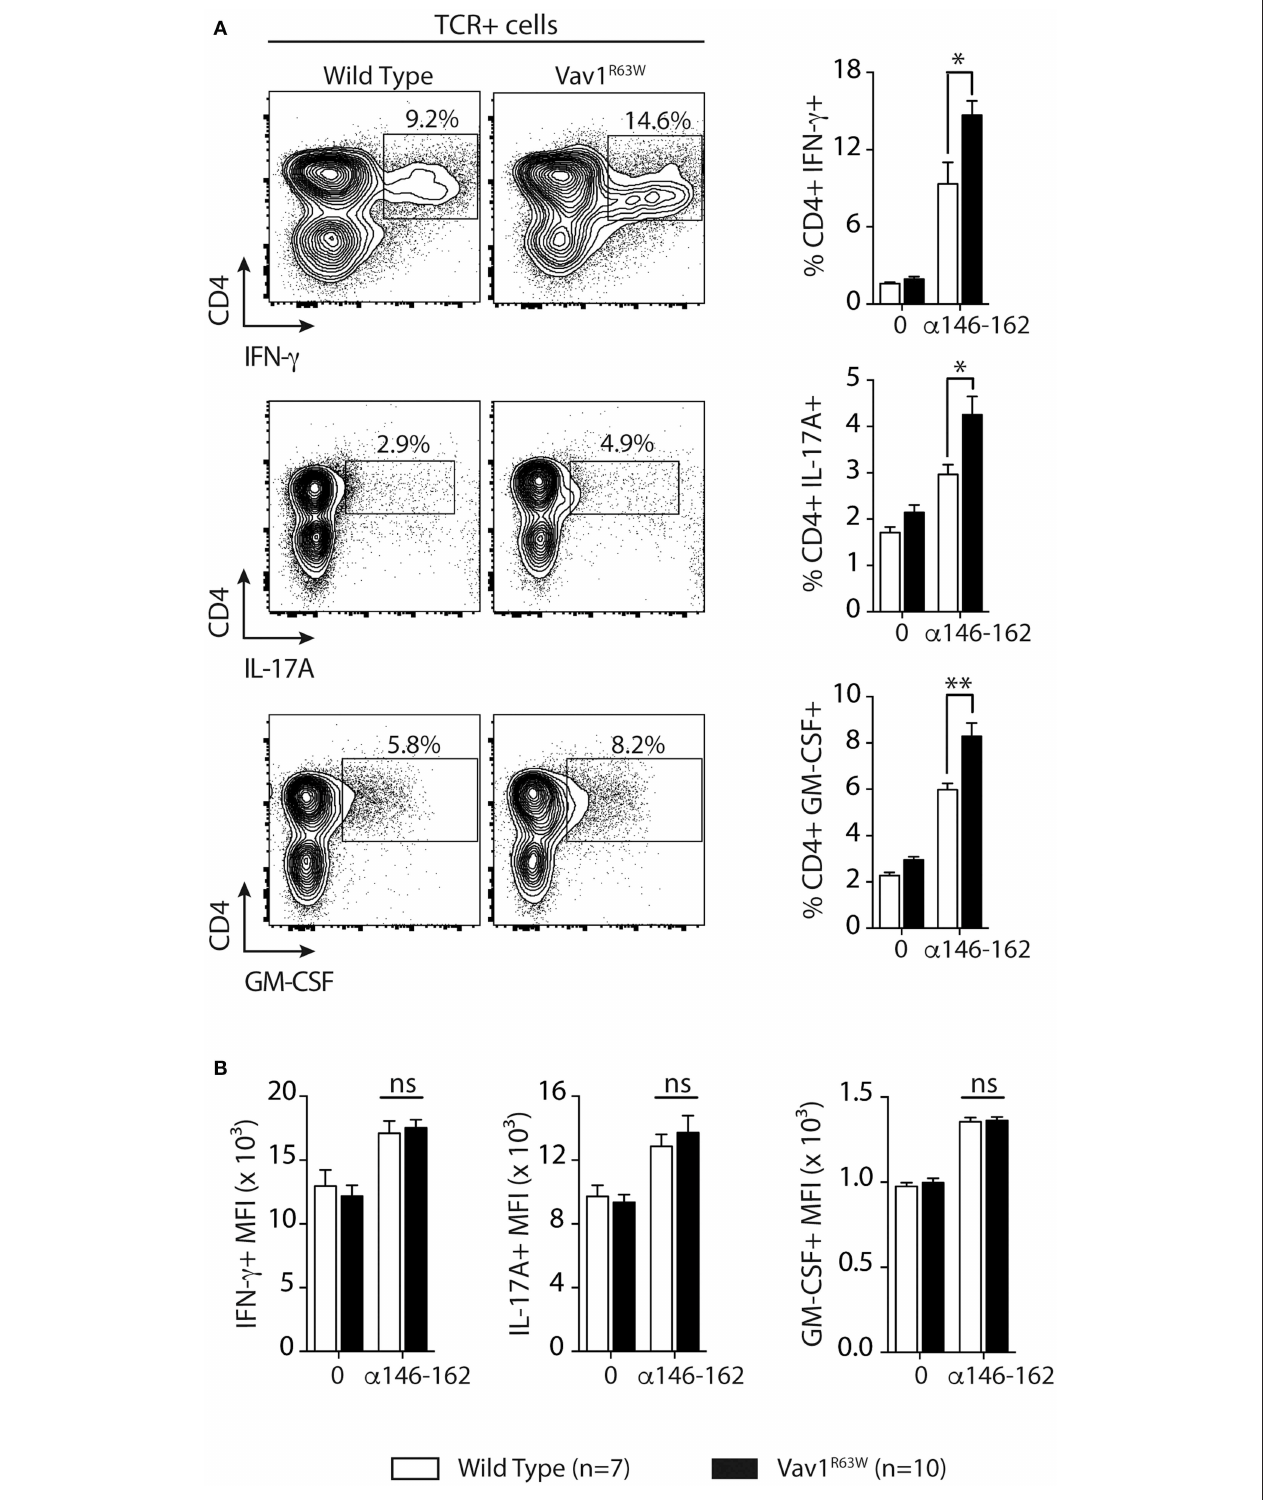
FIGURE 3 | Frequency of CD4 + T cells producing cytokines after tAChR immunization of WT and Vav1 R63W mice. WT or Vav1 R63W mice were immunized with 10 µ g of tAChR in CFA. Draining LNC were harvested 9 days later and stimulated with the α 146-162 immunodominant AChR peptide. (A) Frequency of TCR + CD4 + LN cells producing cytokines was determined by intracytoplasmic staining after 72h stimulation with (1 µ M) or without α 146-162 AChR peptide. (B) Histograms represent the Mean Fluorescence Intensity (MFI) of IFN- γ , IL-17A and GM-CSF expression by TCR + CD4 + LN cells. Data represent a pool of 2 independent experiments. Mann-Whitney test, ns, non-significant; * P < 0.05; ** P < 0.01.